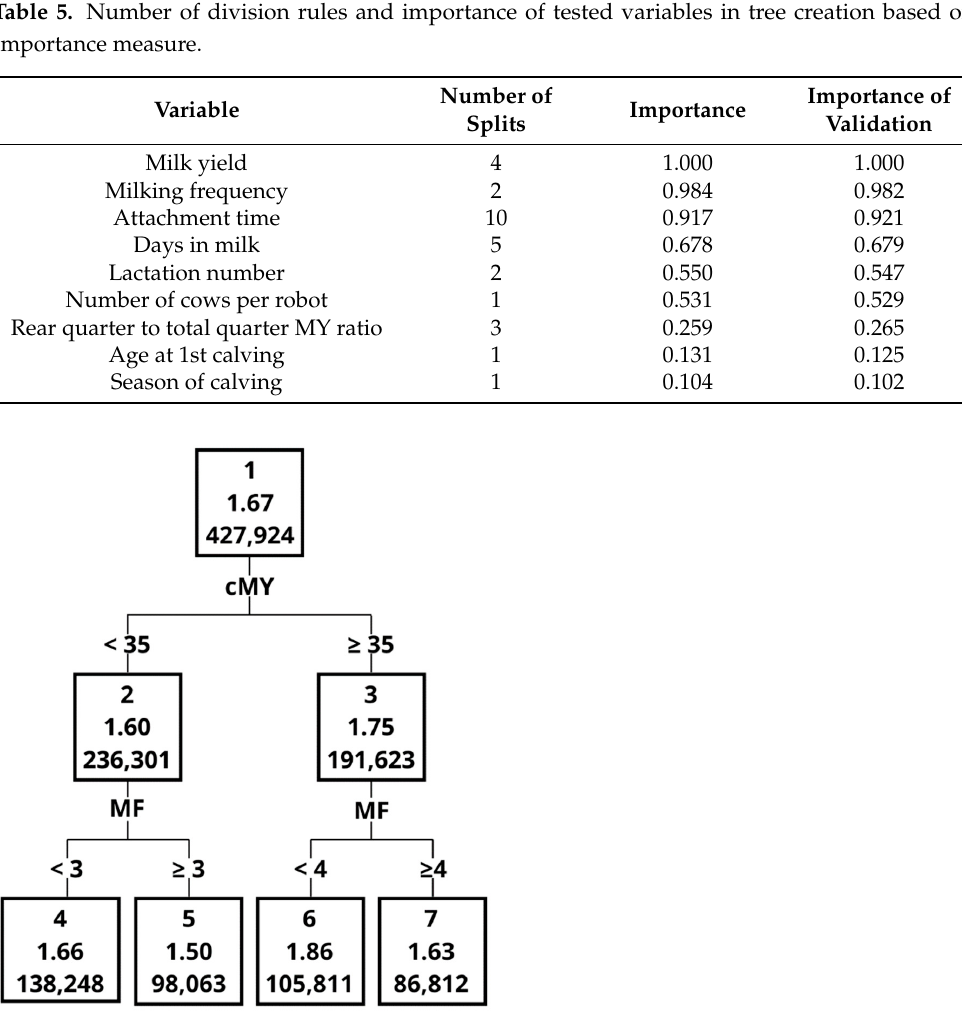
Figure 2. The graphical model of the decision tree—part 1. Abbreviations used in Figures 2–6: cMY—milk yield; MF—milking frequency; AT—attachment time; DIM—days in milk; noL—lactation number; noC—number of cows per robot; RTR—rear quarter to total quarter MY ratio; AFC—age at 1st calving; SC—season of calving.